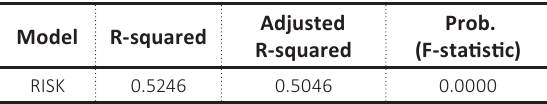
Table 4. The overall model significance